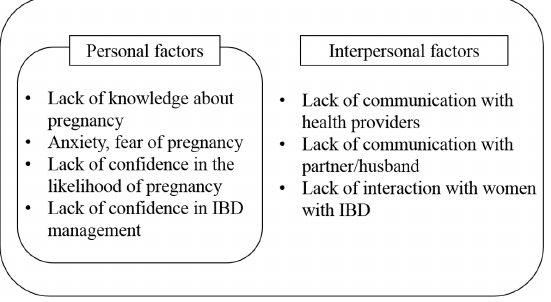
Figure 1. Personal and interpersonal factors related to preconception care of women with inflammatory bowel disease (IBD) based on a needs assessment through interviews and a literature